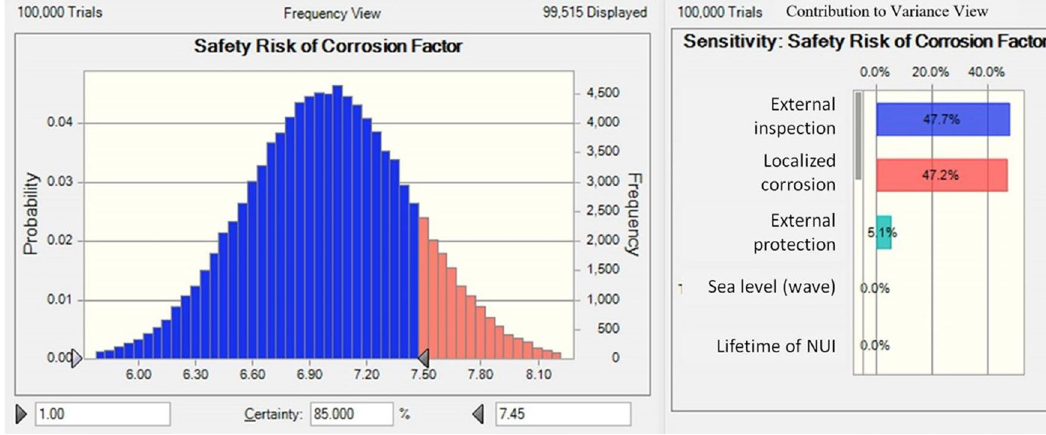
Fig. 3 Safety risk of the corrosion factor for a type A platform